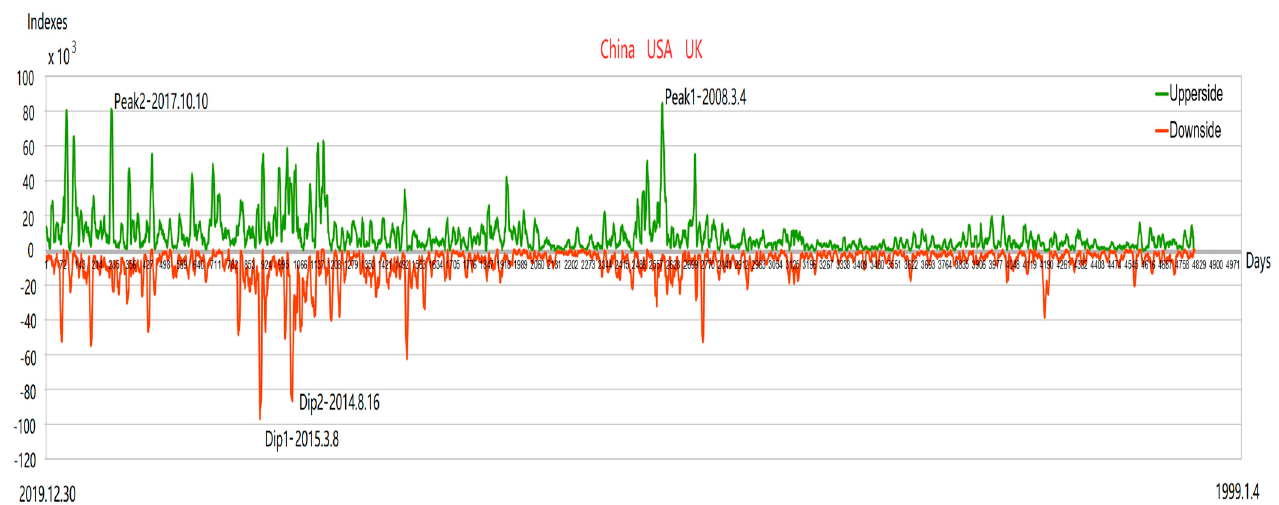
Figure 6. Semi-covariances between gold price and China, USA, and UK from the year 2019 back to Figure 6. Semi ‐ covariances between gold price and China, USA, and UK from the year 2019 back to 1999. Figure 6. Semi ‐ covariances between gold price and China, USA, and UK from the year 2019 back to 1999. Figure 6. Semi ‐ covariances between gold price and China, USA, and UK from the year 2019 back to 1999.